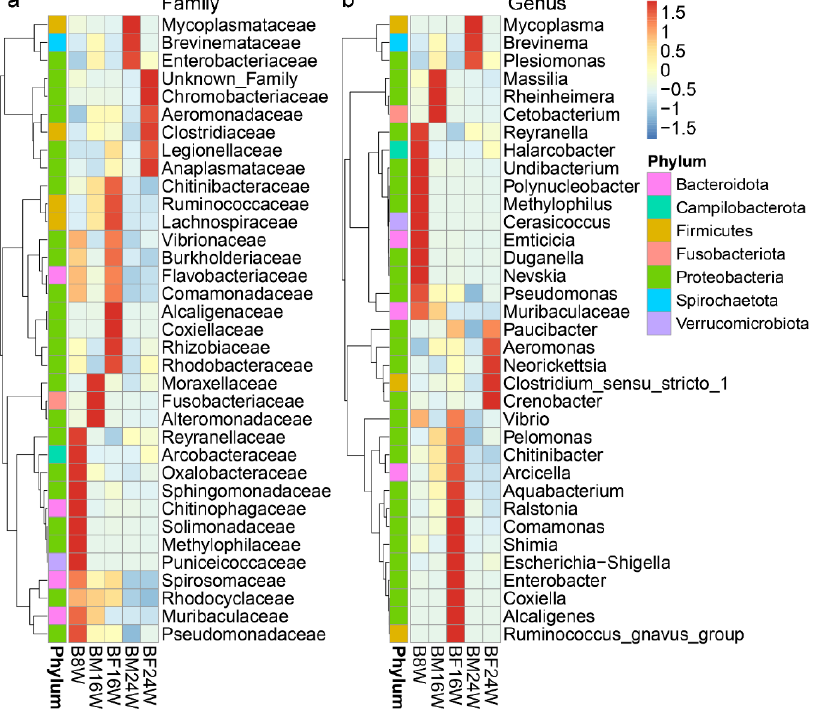
Figure 3. Heatmap of hierarchical clustering of top 35 bacterial families ( a ) and genera ( b ) across age and gender groups of Siamese fighting fish. The left annotation represents gut microbiota at the phylum level. The block of gradients (high and low values) indicates the enrichment of gut microbiota across groups. B8W, 8-week-old Siamese fighting fish; BM16W, 16-week-old male Siamese fighting fish; BF16W, 16-week-old female Siamese fighting fish; BM24W, 24-week-old male Siamese fighting fish; BF24W, 24-week-old female Siamese fighting fish.